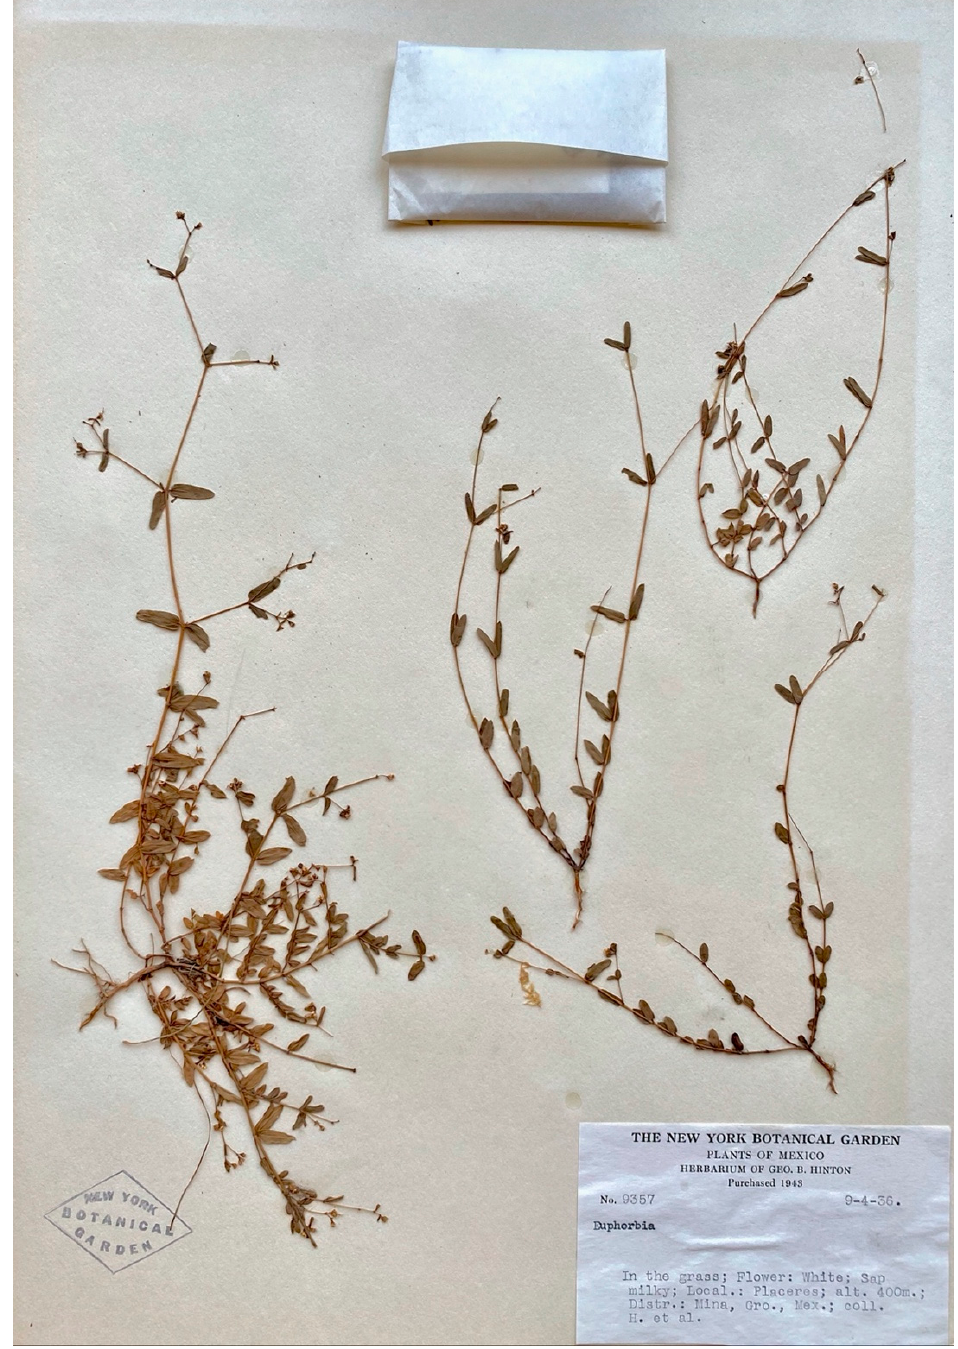
Figure 1. Euphorbia marciae . Hinton et al. 9357 , isotype